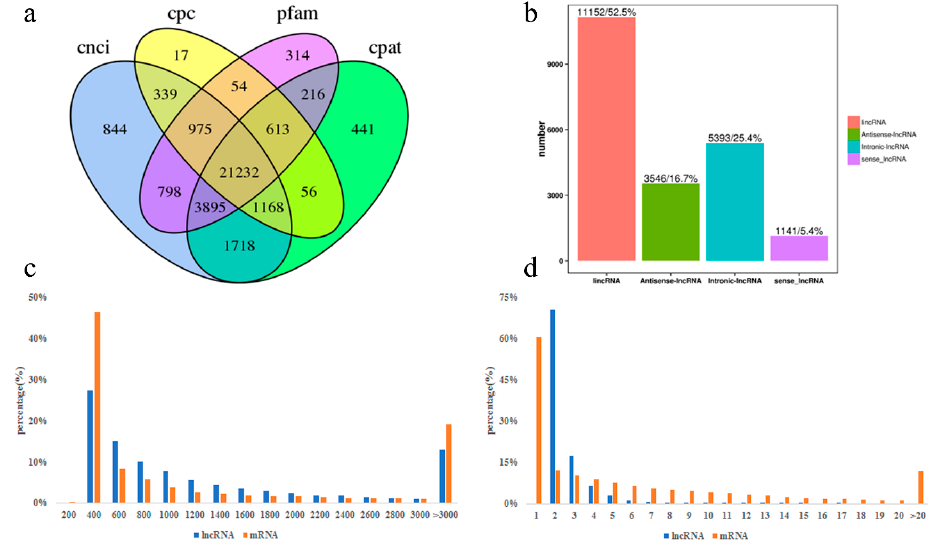
Figure 2. Comparison of the features of goat long noncoding RNAs (lncRNAs) and mRNA. ( a ) Venn diagram showing the predicted lncRNAs with the four computational approaches. ( b ) Type and number of predicted lncRNAs. ( c ) Length per transcript of goat lncRNAs and mRNA. ( d ) Exon numbers per transcript of goat lncRNAs and mRNA.